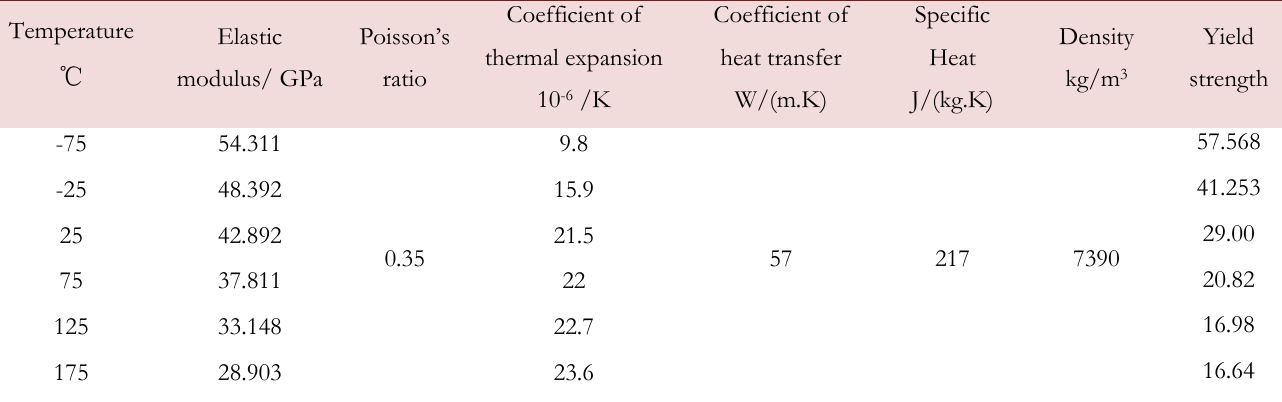
Table 2: Thermomechanical property of Sn3Ag0.5Cu.